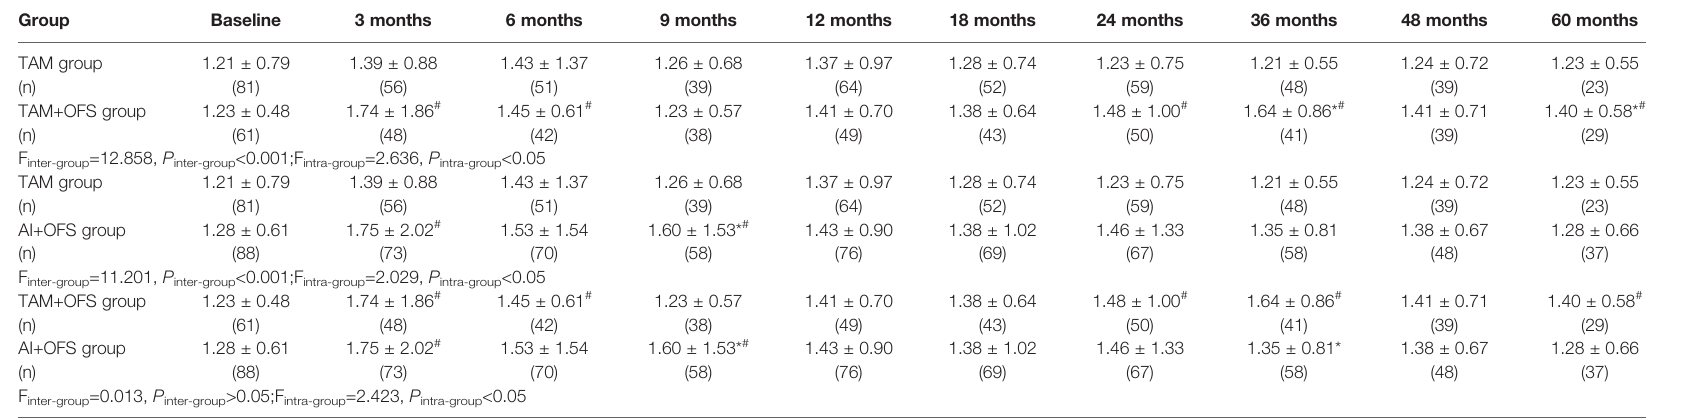
F inter-group =0.013, P inter-group >0.05;F intra-group =2.423, P intra-group <0.05 n represents patient number. *P value < 0.05, compared to the other group at the same time-point. # P value < 0.05, compared to the baseline at the same